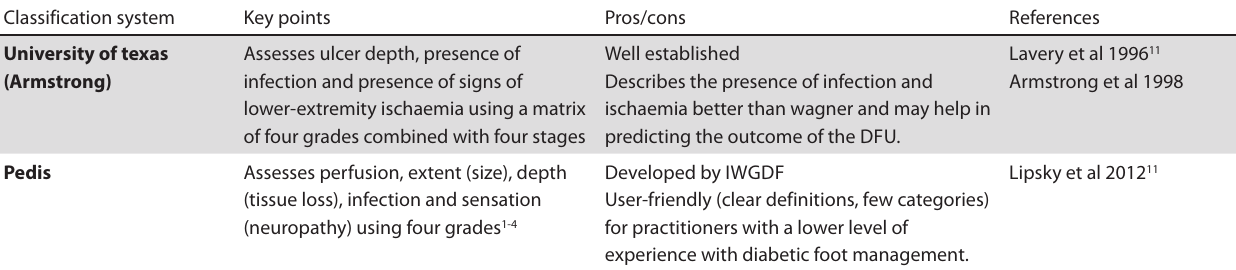
Table 8: Key features of the recommended classification systems adapted from international best practice Classification